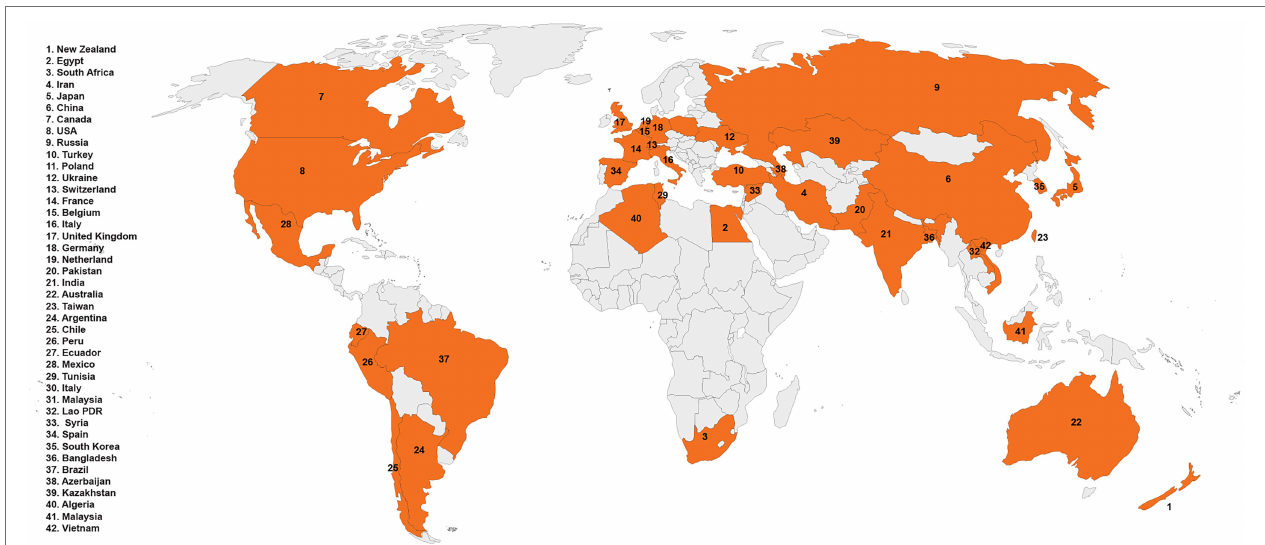
FIGURE 1 | Geographical distribution of Rhizoctonia